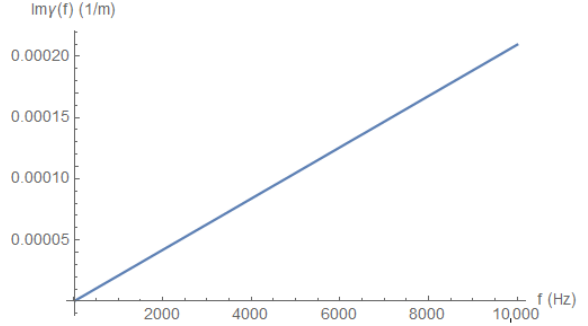
Figure 8. Im γ high frequency dependence.